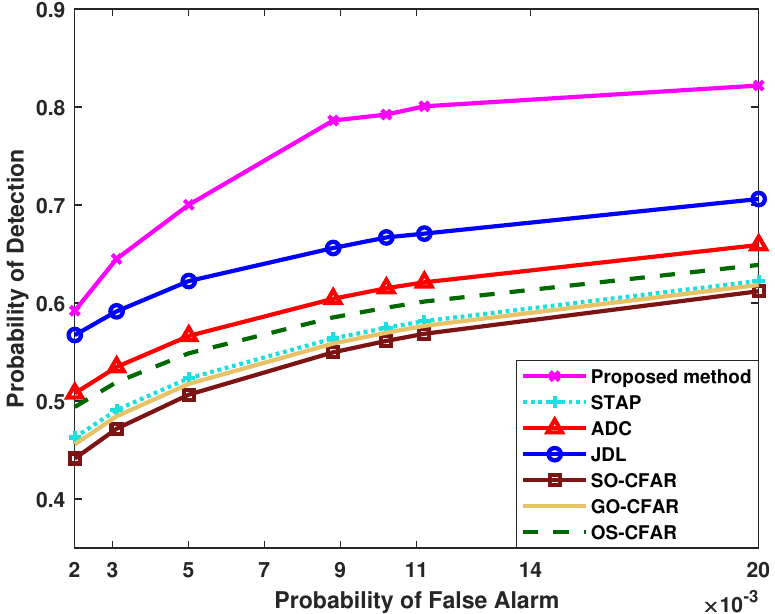
Figure 6. Probability of detection versus probability of false alarm for different